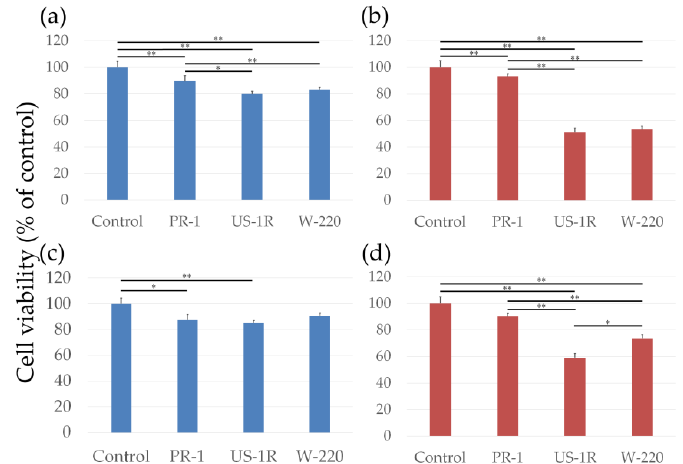
Figure 2. Viability of BEAS-2B cells exposed to 100 μg/mL of Flotube 9110 (FT9110). In ( a , b ) the cell